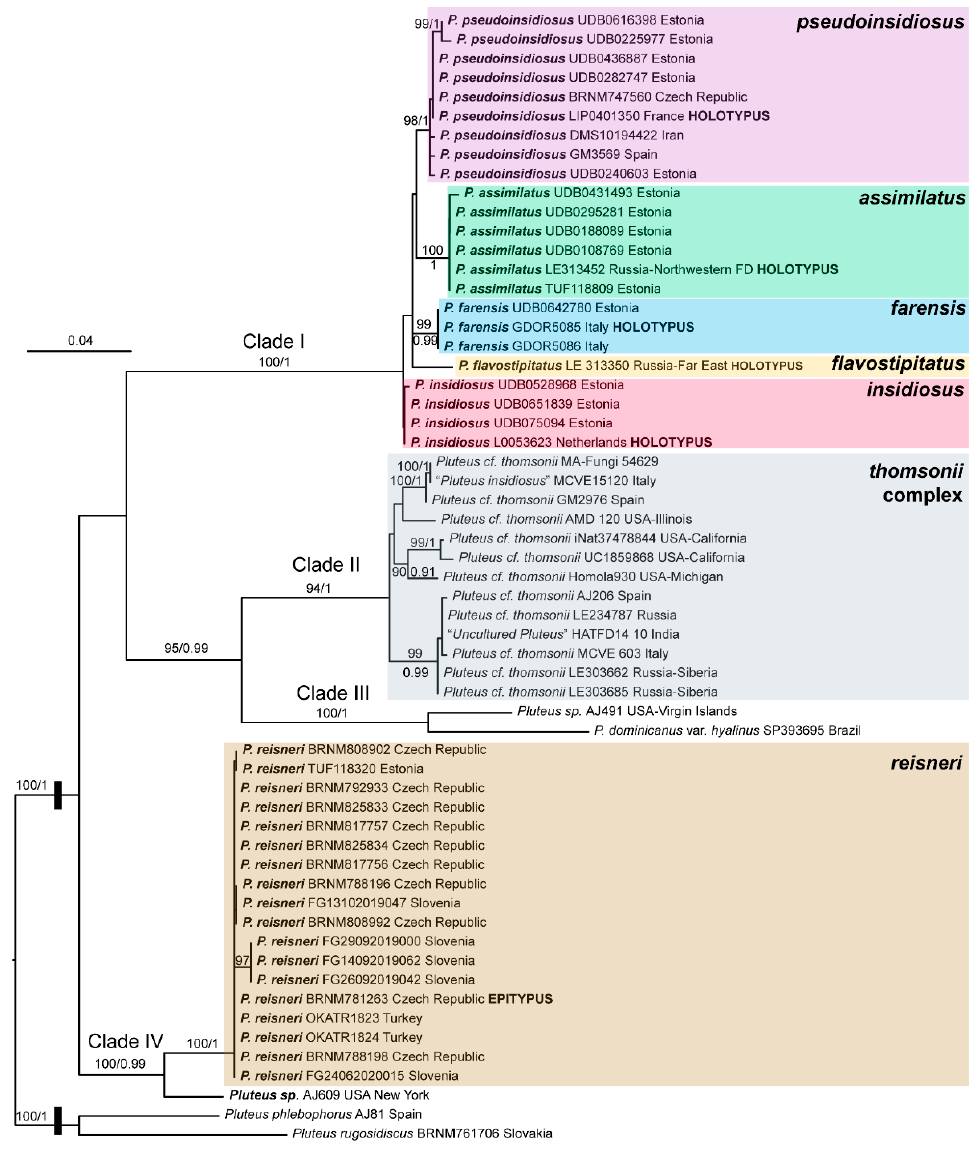
Figure 1. Best tree from the ML analysis of the nrITS + TEF1- α dataset. Bootstrap values ≥ 70% and posterior probabilities ≥ 0.90 are indicated on or below the branches. The root length has been reduced to facilitate graphical representation.